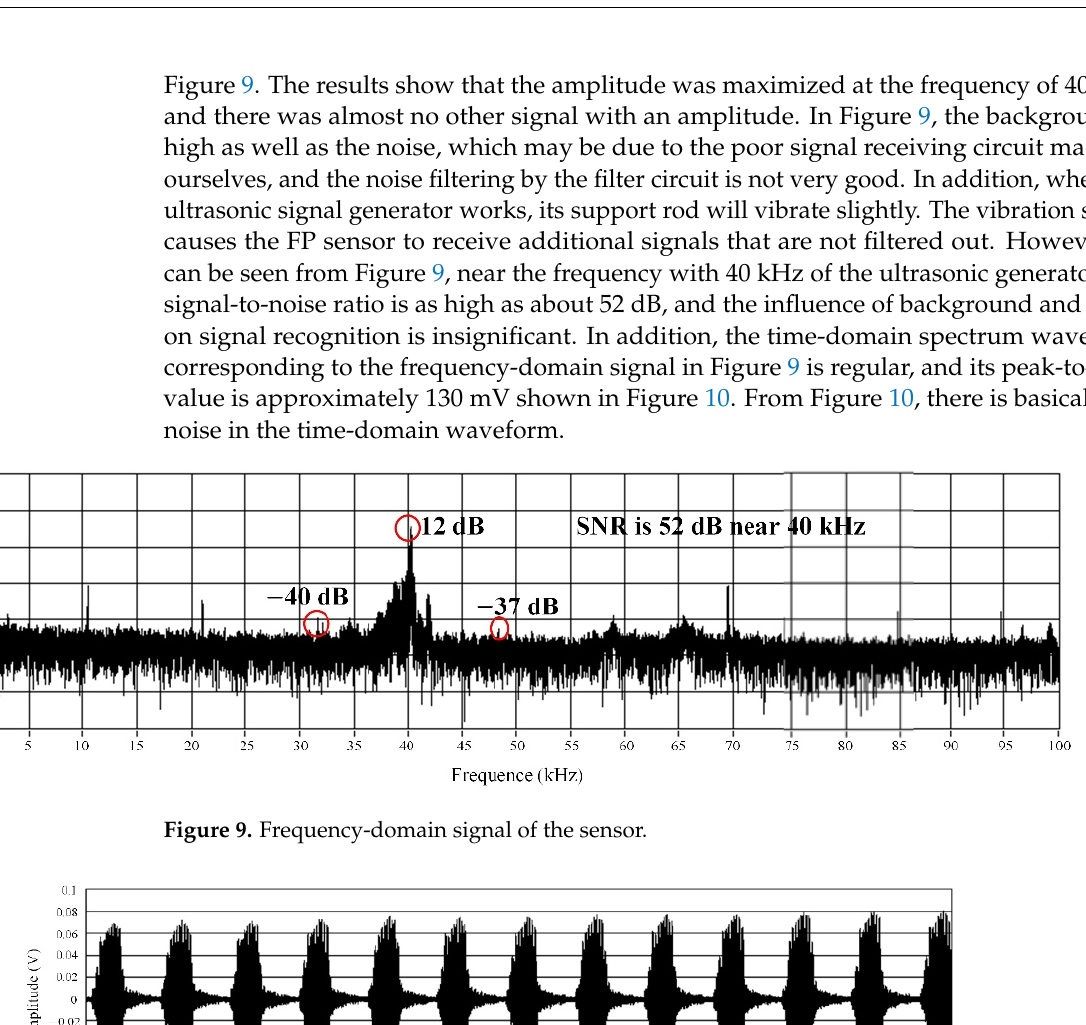
Figure 8. Schematic of the ultrasonic signal testing system.